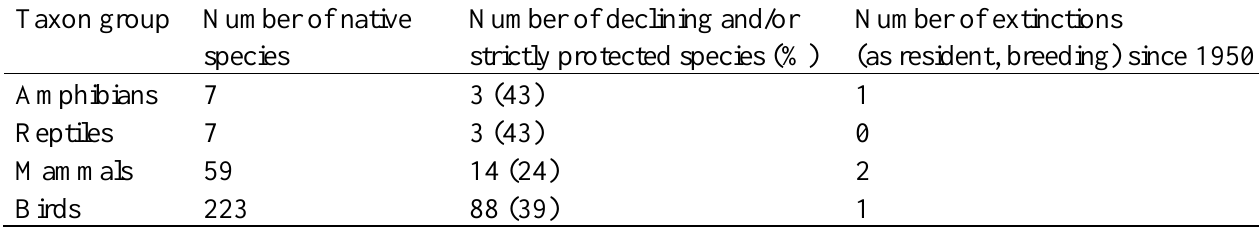
Table 3. Conservation status (Britain). Data from IUCN (2008) and [19]. Mammals include terrestrial and marine natives, birds are native breeding